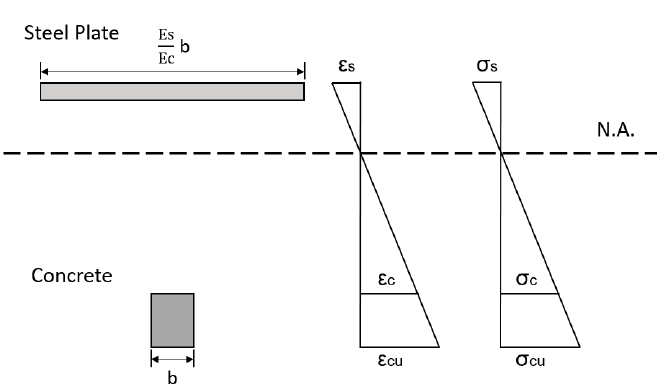
Figure 10. Section analysis, strain and stress distribution of strut-and-tie beam specimen.